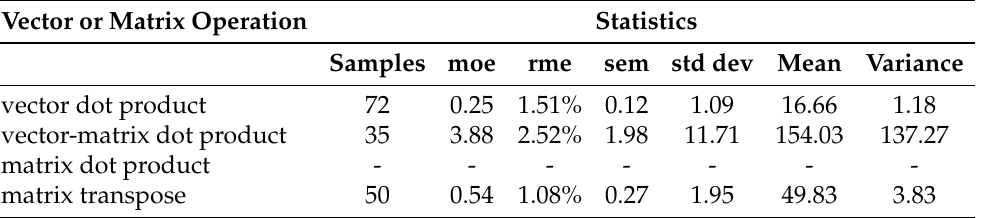
Table 25. Raspberry Pi IV benchmark statistics for vector and matrix operations with k = 128 (times in ms).